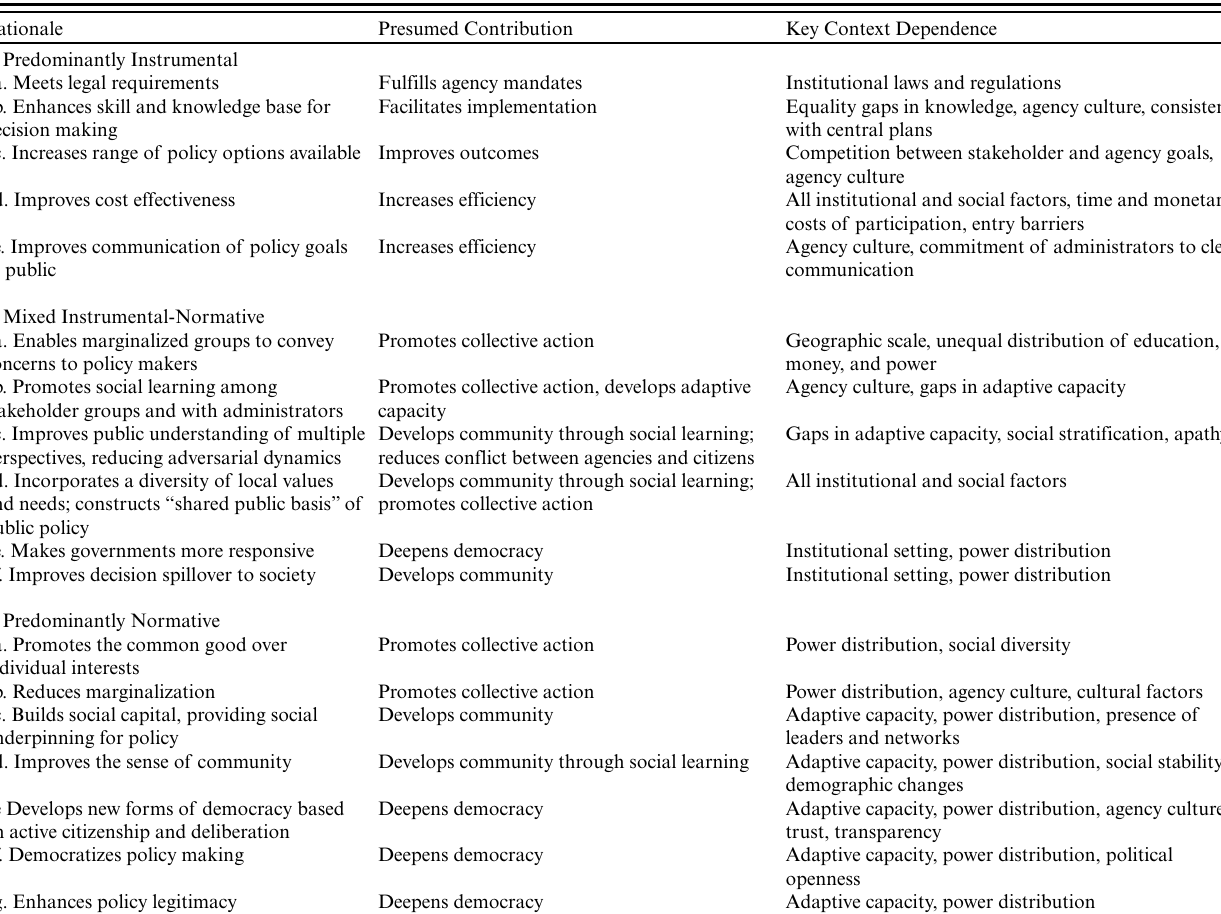
Table 1 . Rationale for public